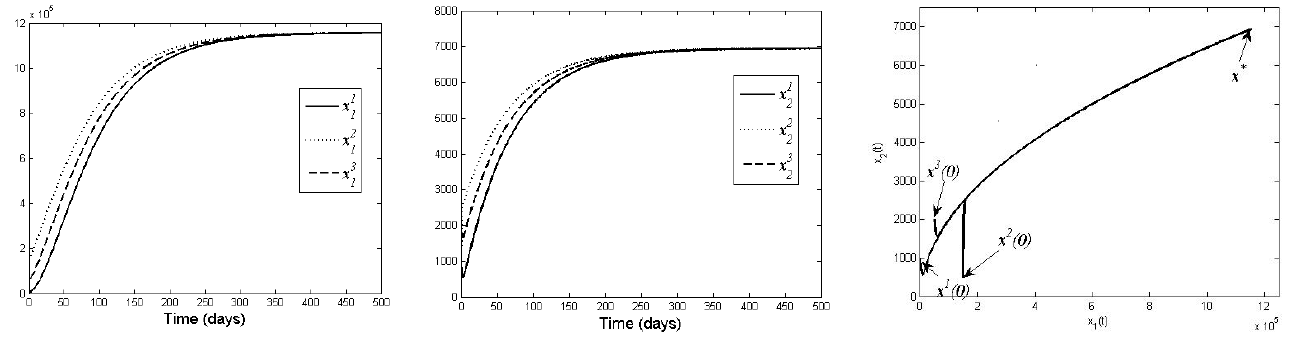
Figure 4. Solution of (1)–(2) with different initial values x 1 (0) = (0, 1000), x 2 (0) = (150,000, 500), and x 3 (0) = (50,000, 2000).